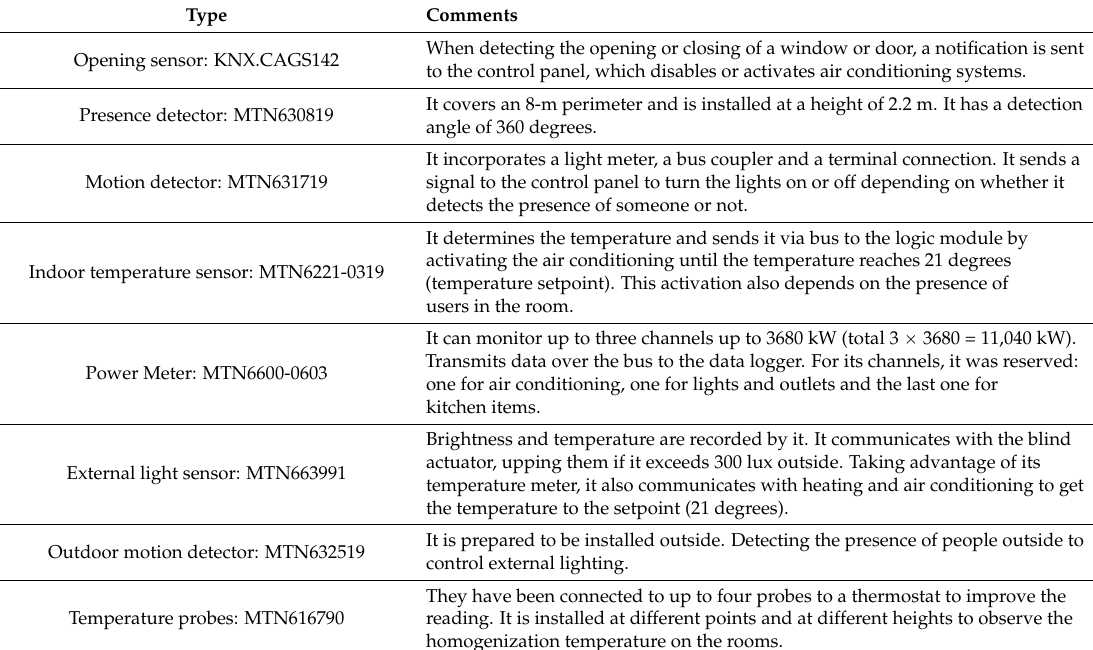
Table 2. Types and characteristics of sensors and actuators